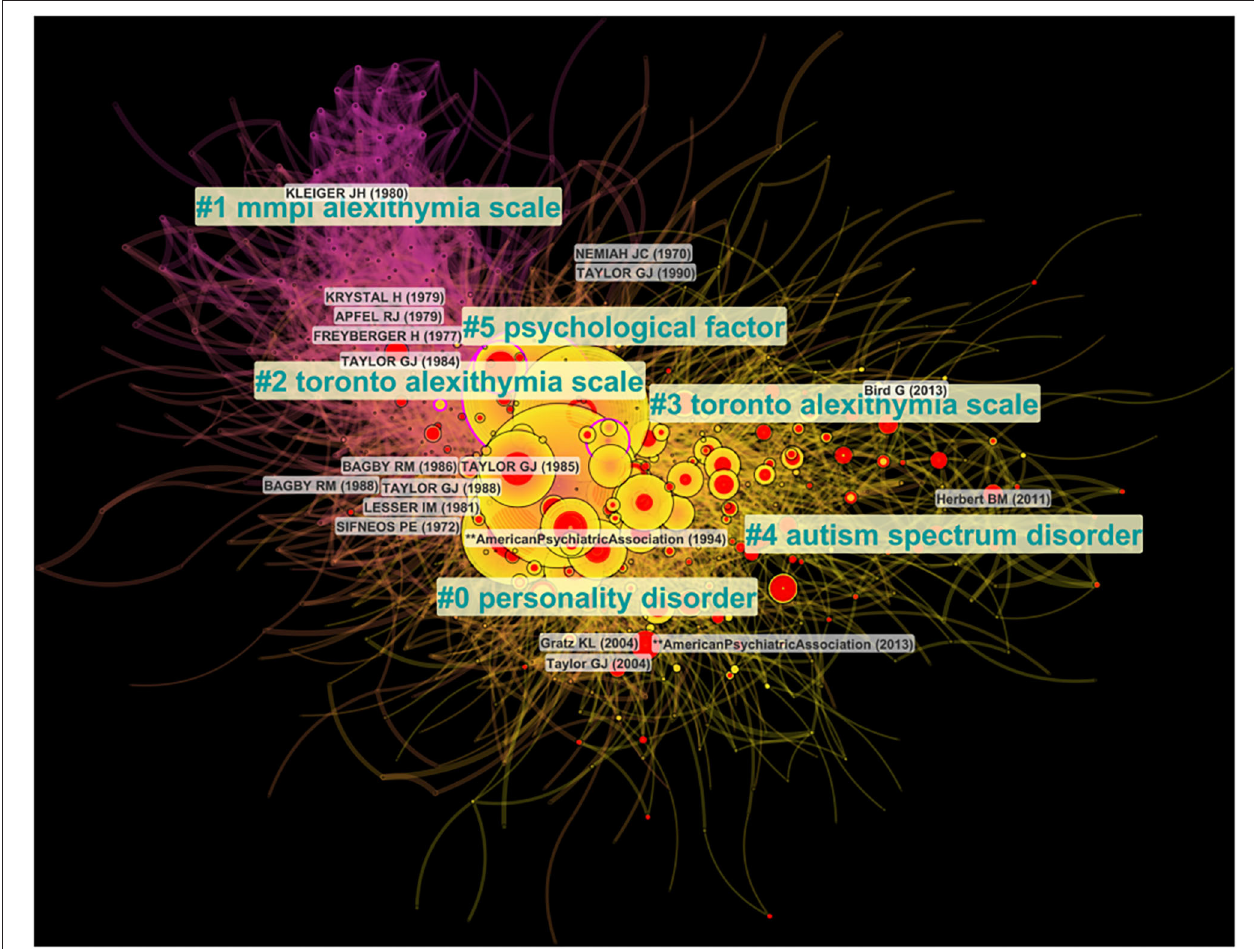
FIGURE 2 | Cluster view of the document co-citation analysis (DCA) generated using CiteSpace Version 5.6.R5 (48–50). Modularity Q = 0.51; average silhouette = 0.75. Colored shades indicate the passage of the time, from past (purplish) to the present time (reddish). Colored tree rings refer to the nodes with high betweenness centrality (purple tree rings) and burstness (red tree